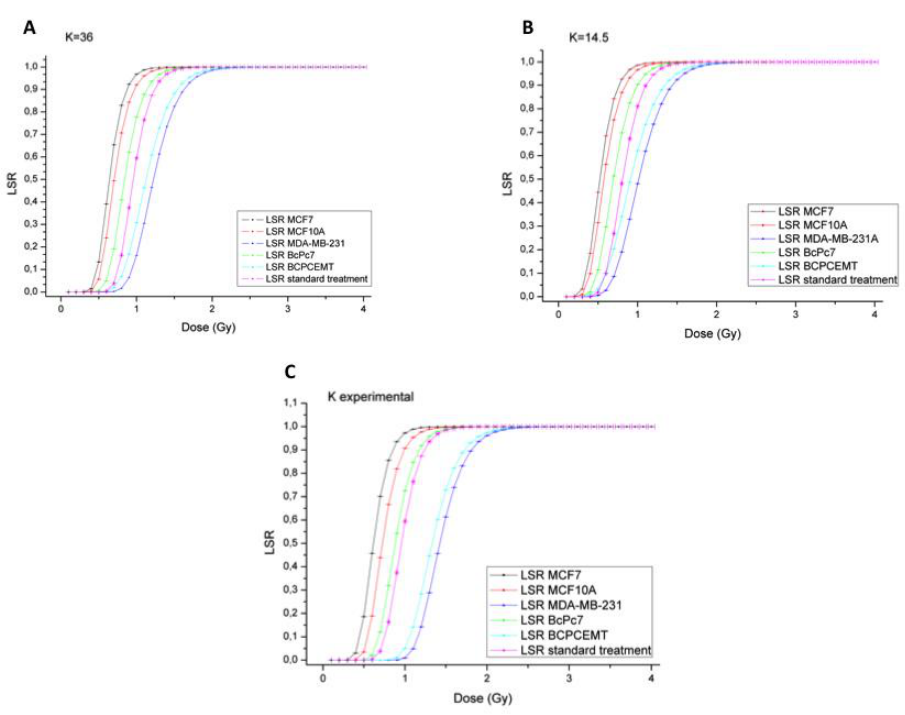
Figure 2. Local disease-free survival rate (LSR) curves with k = 36 ( A ) and k = 14.5 ( B ), as well as k values experimentally calculated ( C ) on BC cells exposed to increasing doses of therapeutic X-rays. The data shown are represented with their own error in x and y .